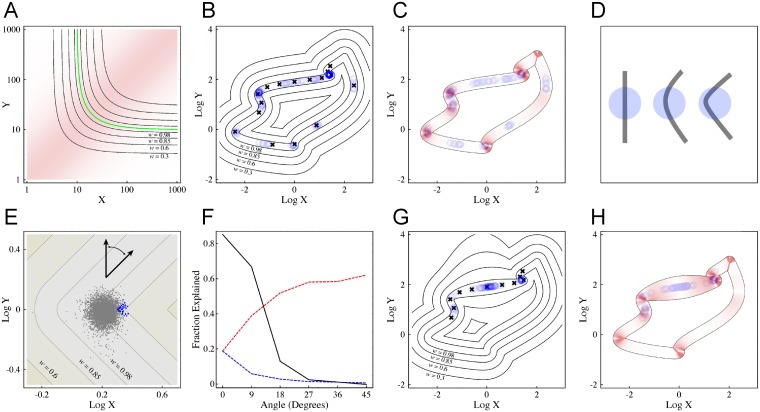
Evolutionary trajectories and epistasis on fitness ridges.(A) A variety of biologically realistic scenarios produce landscapes with continuous fitness ridges that resemble those in the LP model. Here we show a landscape for Z = XY/(X+Y), which models a scenario in which two gene products work together, but with a cost associated with expressing each. Compare with Fig 3A and 3B. (B) Evolution on an arbitrary fitness ridge-landscape, in which the optimal phenotype (w = 1) is defined by a parametric curve that traces a closed loop in the X-Y plane: ln(X) = sin(2t) cos(2t)– 2 cos(t), ln(Y) = (cosh(t) + 5 sin(t))/4, -π < t < π, and for points elsewhere in the plane, fitness falls off as a function of the shortest distance to the parametric curve. Black crosses indicate initial positions of populations chosen for 22 independent simulations. A combination of developmental and environmental noise was used (σdev = σenv = 0.05, as in Fig 6C). Blue circles show, for each simulation run, the population mean values of ln(X) and ln(Y) at 11 timepoints, sampled once every 500,000 generations between 5,000,000 and 10,000,000 generations. The results show that corners in the fitness ridge function are attractors: populations that start at a corner tend to stay there, while those starting near enough to a corner are drawn there. At three locations along the curve, there are two corners in close proximity: (ln(X), ln(Y)) ≈ (-1.5, 1.25), (0, -0.75), and (1.5, 2). Nearby populations are always drawn more strongly to the sharper of the two corners. (C) Maximum epistasis in the vicinity of a high-fitness ridge. This figure shows only the region of the fitness landscape from Fig 7B where w > 0.95. Locations of blue circles are identical to Fig 7B, representing sampled population locations at late time points. The red shading indicates the maximum possible epistasis at any given point, derived from Eq. (S85) in S1 Text. Epistasis is maximized in the vicinity of corners in the fitness ridge, and minimized where the X-Y slope (orientation) of the ridge is close to vertical or horizontal. (D) Conceptual explanation for the attractiveness of corners. Because noise forces populations to sample from nearby regions of the fitness landscape, its effect may be viewed as a form of local averaging. As sufficiently thin fitness ridges may be conceptualized as segments of curves in the X-Y plane (black), the average value of fitness within any region (blue) may be equated with the arc-length of the optimal fitness contour that is contained within it. For simple regions, the greater the curvature of the contour, the more arc length can usually be contained within it. (E, F) Influence of ridge orientation on epistasis. In D, an LP-like fitness landscape (s = 1; zopt = 1, as in Fig 6C) was rotated by 45°, so that its arms become diagonal, while the orientation of the corner (slope of the optimal fitness contour at the corner) becomes vertical (the angle of rotation is indicated by the arrows). A snapshot of an evolutionary simulation (σdev = σenv = 0.05) is shown; blue and gray dots representing “case” and “non-case” individuals, respectively. As expected, the population localizes near the corner, but the individuals with the highest phenotype values (cases) are outliers only in X relative to the rest of the population. Panel E summarizes a variety of simulation runs in which the same fitness landscape was gradually rotated from its original orientation (0°) to 45°. The black curve gives the fraction of case-control phenotype differences attributable to epistasis (for cases with relative fitness < 0.9; i.e. the same quantity plotted in Fig 6E and 6G). The red and blue dashed lines indicate the mean fraction of the phenotypic variance of the population that is attributable to variance in X and Y, respectively. Note that epistatic explanation for disease vanishes as the corner orientation moves from diagonal to vertical. At the same time, phenotypic variance goes from being bi-genic to effectively monogenic. (G) Effect of variable fitness fall-off. In this simulation, the fitness landscape in B was distorted by spreading apart the fitness contours in a relatively straight part of the landscape lying between two corners. The meanings of black and blue symbols are as in panel B. The results show that locally flattening the fitness landscape destabilizes the corner at (-1.5, 1.25). However, the sharper corner near (1.5, 2) continues to be a strong attractor. The evolutionary simulations presented in this figure are described in greater detail in Methods. (H) Maximum epistasis in the vicinity of a high-fitness ridge. The figure presents a map of maximum possible epistasis as a function of location along the high fitness ridge in panel G, using the same approach as in panel C. Here we see that the locations to which populations are drawn by “survival of the flattest” may display little or no potential for epistasis.